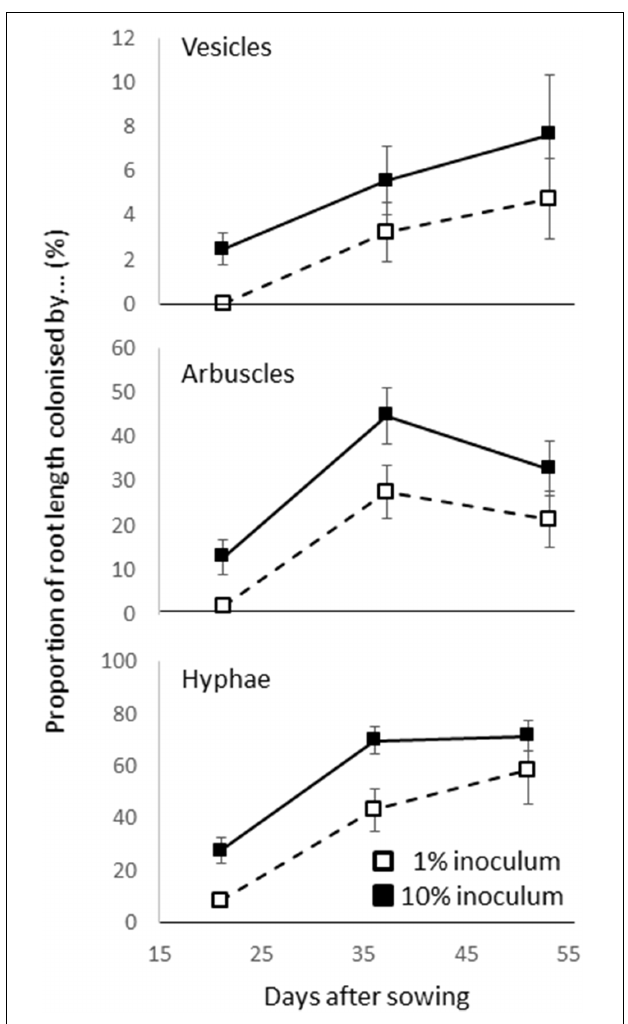
FIGURE 1 | Arbuscular mycorrhizal (AM) colonization of roots in preliminary time course experiment in which cultivar Azucena was inoculated with 1 and 10% inoculum and the presence of vesicles, arbuscles, and hyphae were assessed on three occasions. Bar is standard error ( n =